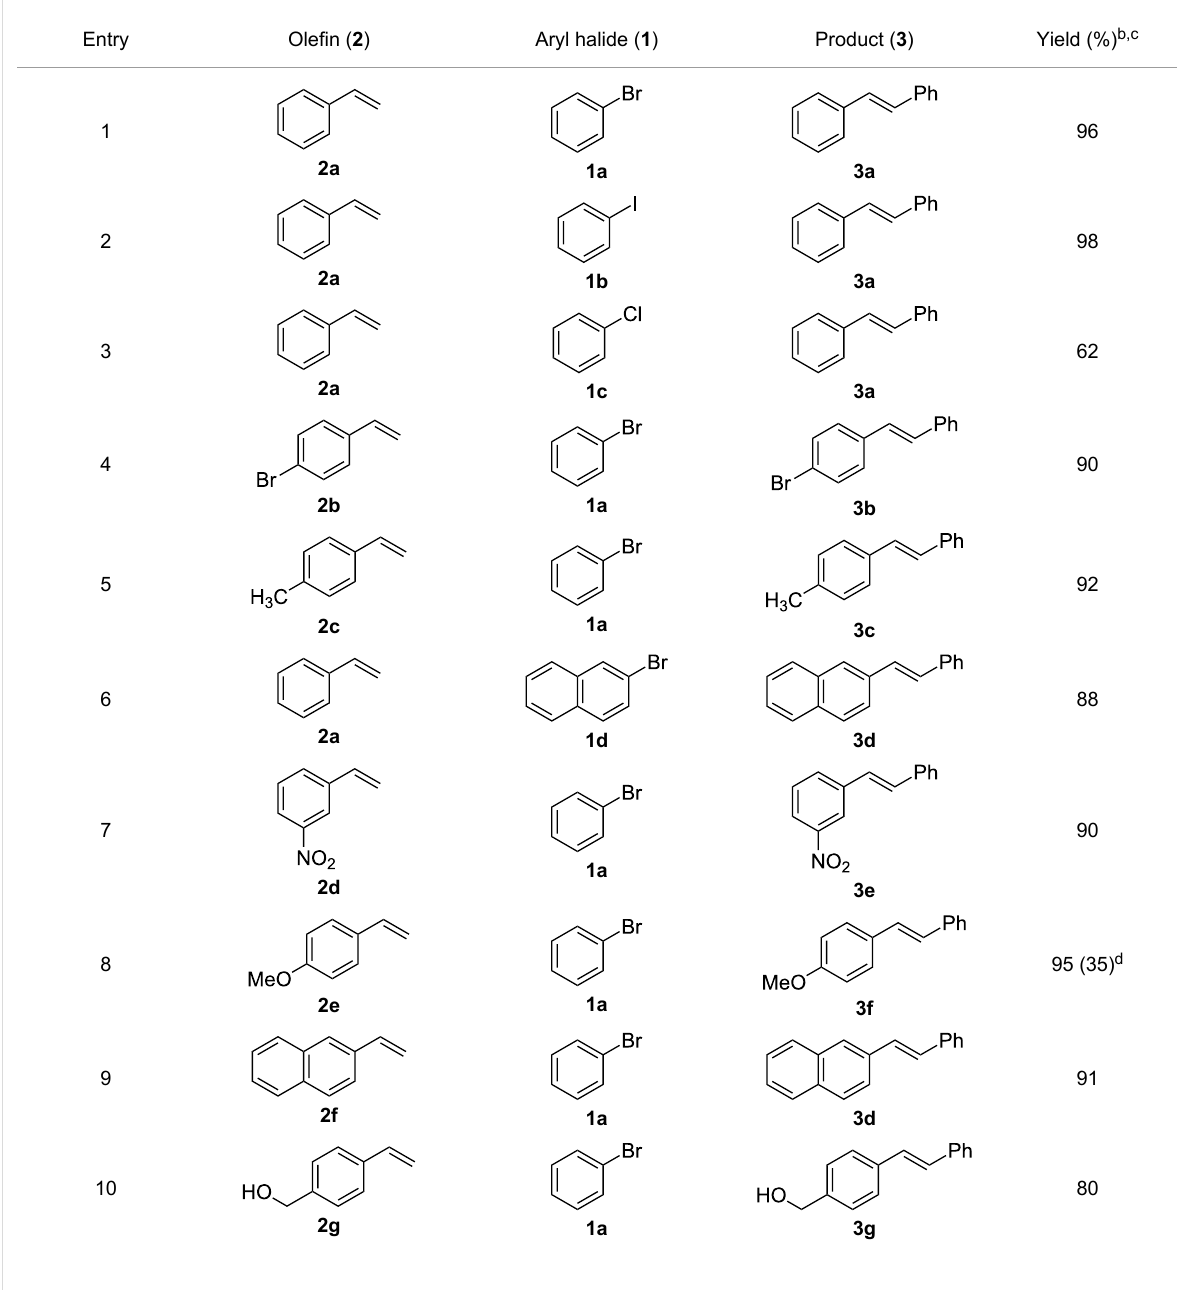
Table 2: Heck reaction of olefins and aryl halides: Scope of substrate.